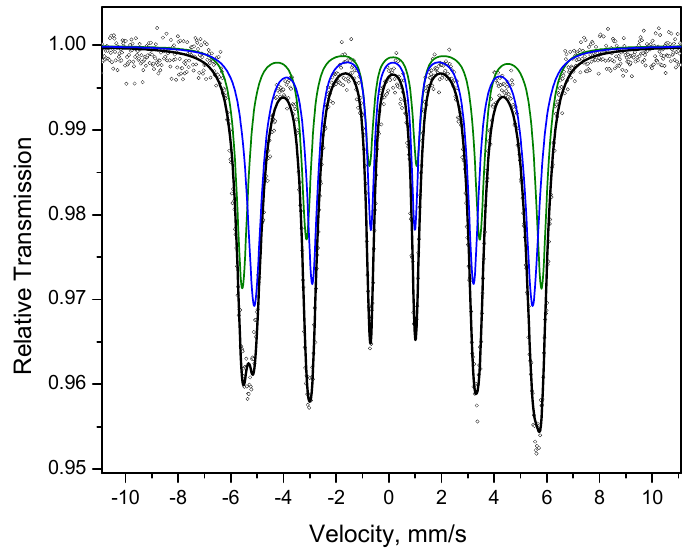
Figure 15. Mössbauer spectrum of the annealed powder treated in HCl solution: dots—experimental data, black line—spectrum represented as a superposition of two sextets (green and blue lines).